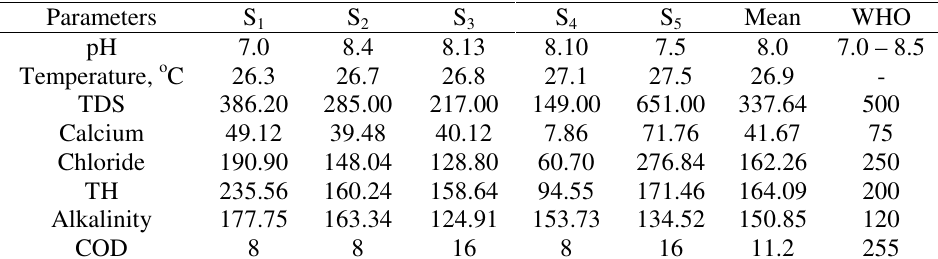
Table 3. Comparison of physicochemical parameters of groudnwater, Telungupalayam area (in mg/L) with standard values (WHO